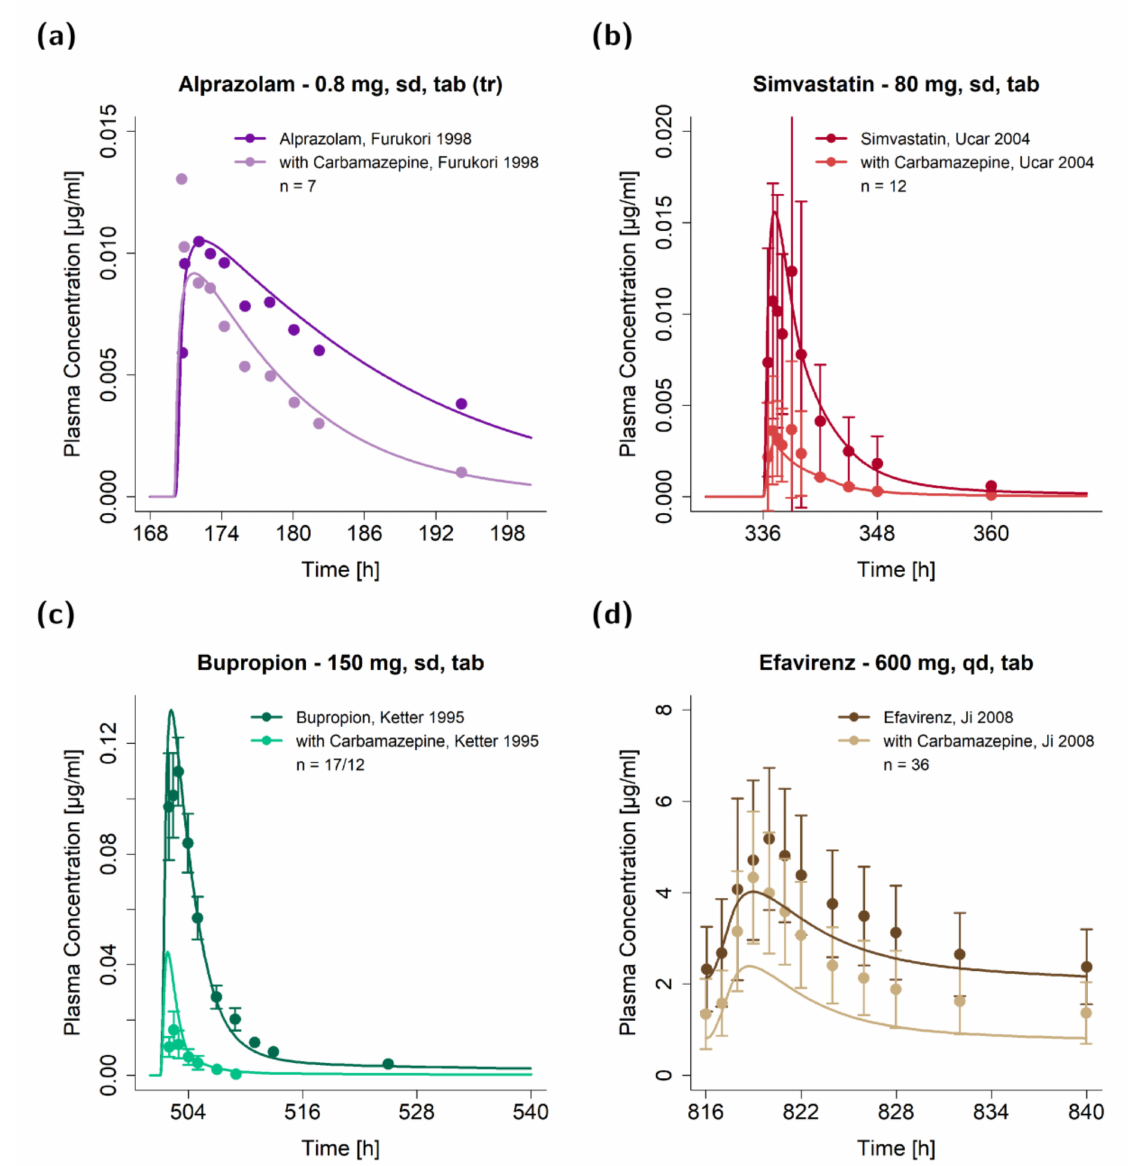
Figure 5. Victim drug plasma concentration − time profiles of the modeled drug–drug interactions with carbamazepine as perpetrator drug. Predictions of the victim drug plasma concentrations during the ( a ) carbamazepine − alprazolam DDI [81], (b) carbamazepine − simvastatin DDI [7] ( c ) carbamazepine − bupropion DDI [8] and ( d ) carbamazepine − efavirenz DDI [10] are shown in comparison to observed data. Observed data are shown as dots ± SD (if available); predictions are shown as solid lines. Details on the study protocols and model simulations of all investigated DDI studies are provided in the Supplementary Materials. md: multiple dose, n: number of individuals, sd: single dose, tab: